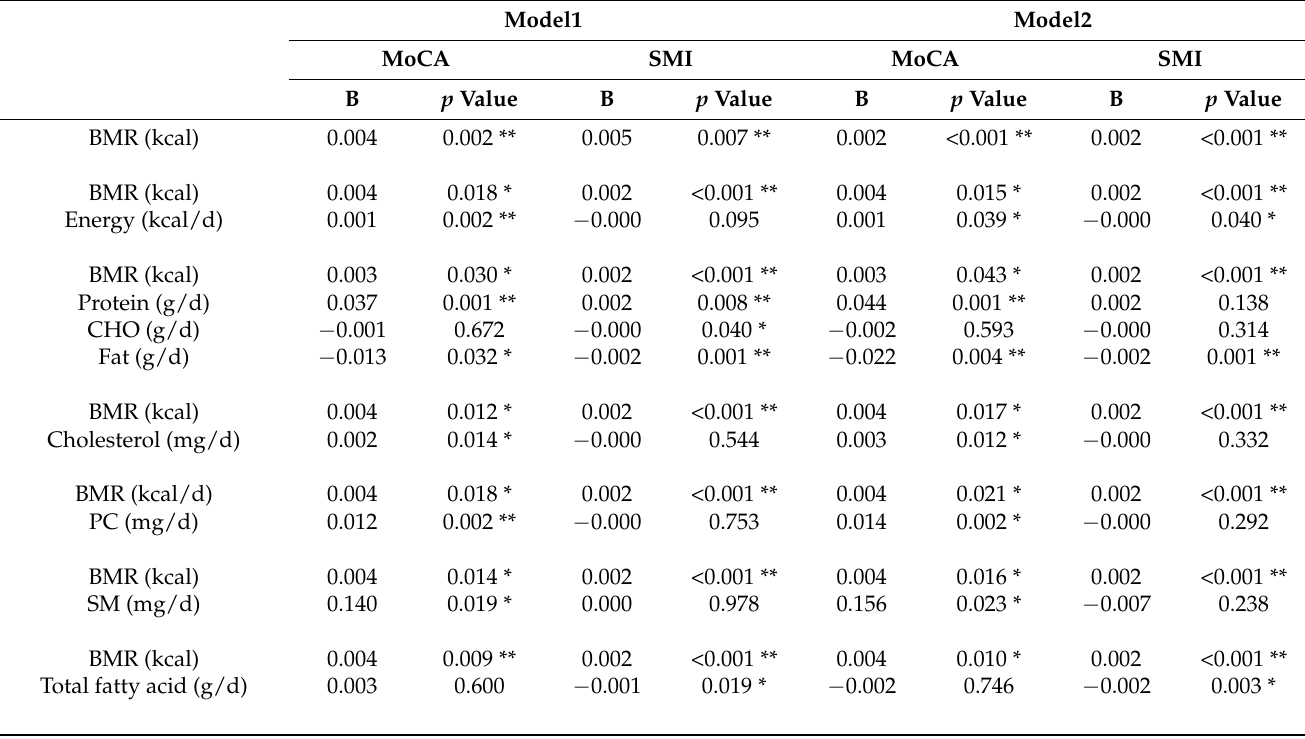
Table 2. Multiple linear regression models predicting MoCA score and